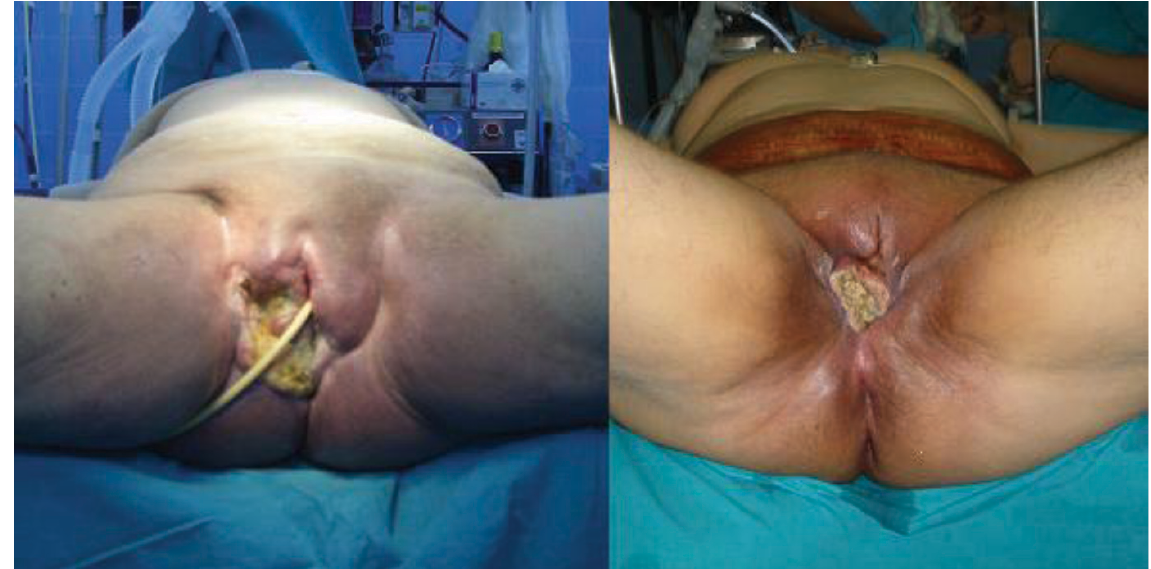
Figure 2. Large perineal